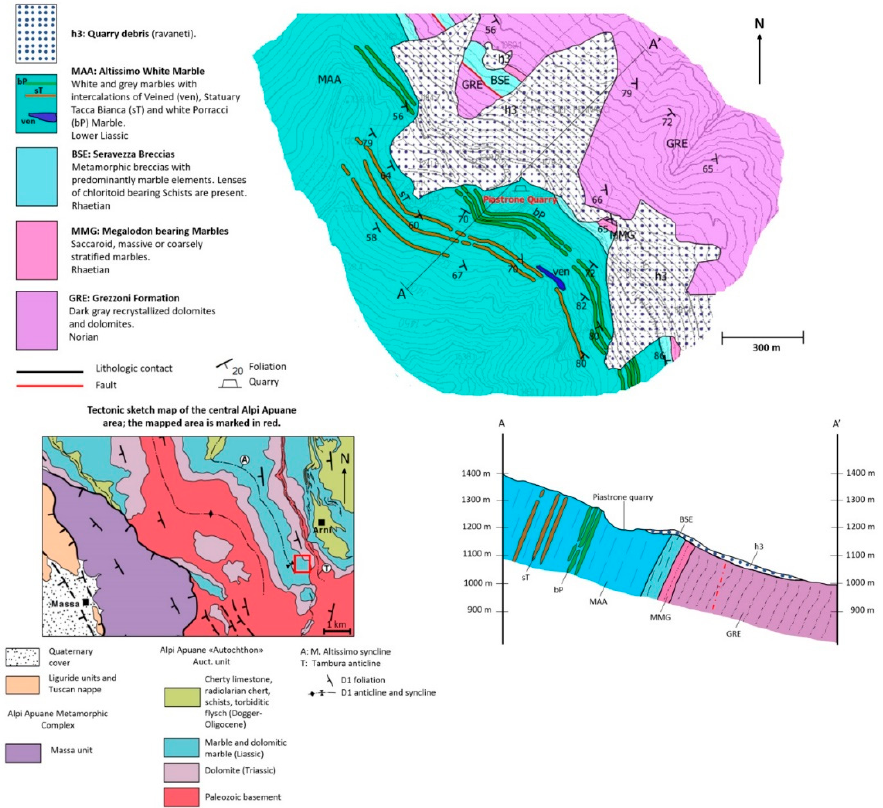
Figure 2. Geological map of the “Retro Altissimo” extraction district [55]; location of Piastrone quarry is marked in red.